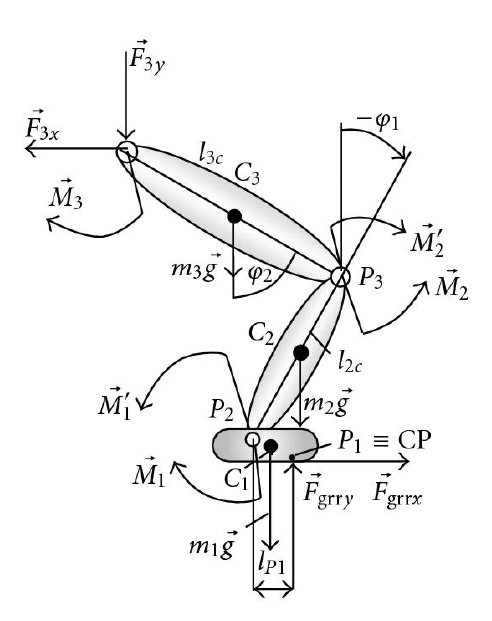
Fig. 2 Schematic diagram of the force on the lower limb system at the moment of